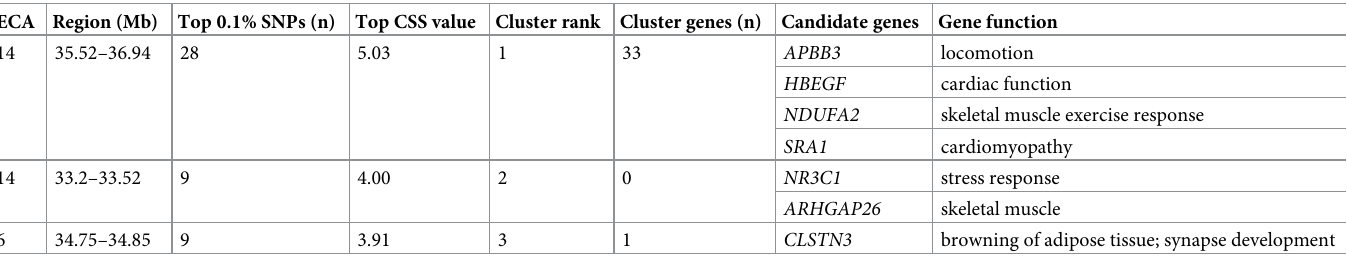
Table 1. Selected genomic regions among top 0.1% SNPs identifying core genes targeted by selection for the Australian racing